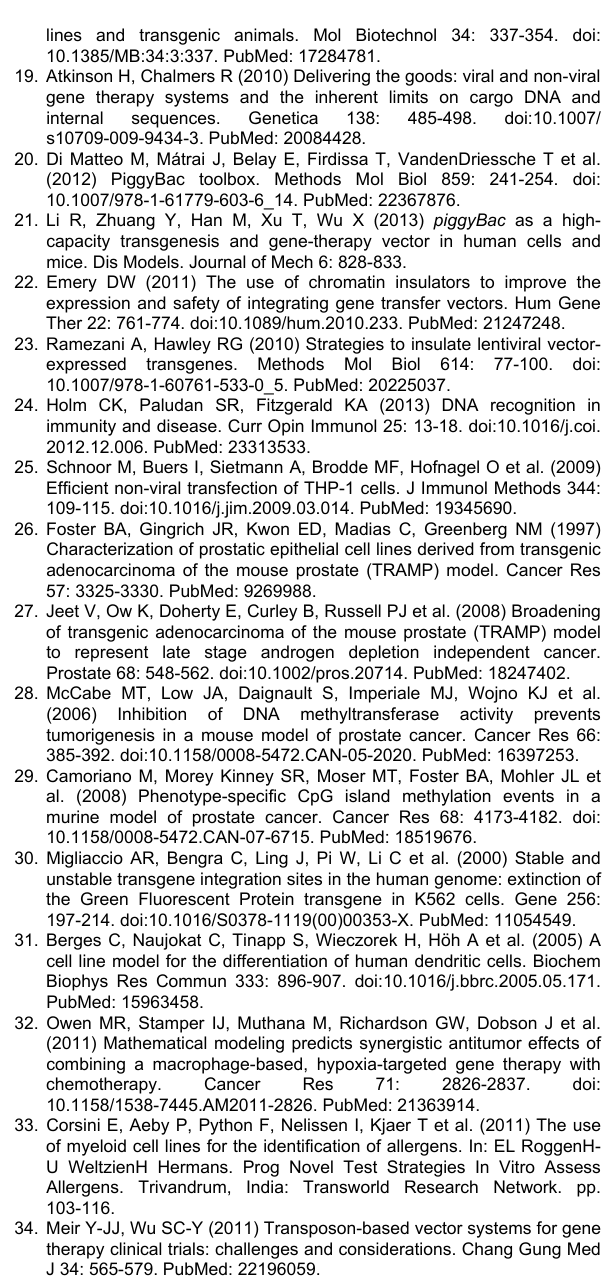
Table S1. Efficiencies (%) of transient transfections of the cell lines after 48